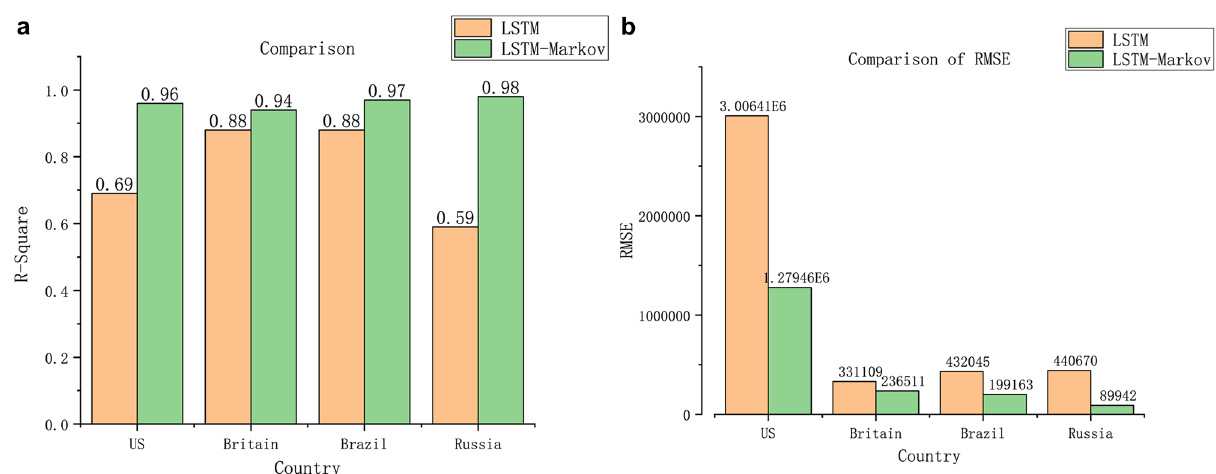
2 and RMSE between LSTM and LSTM-Markov model, a represents R